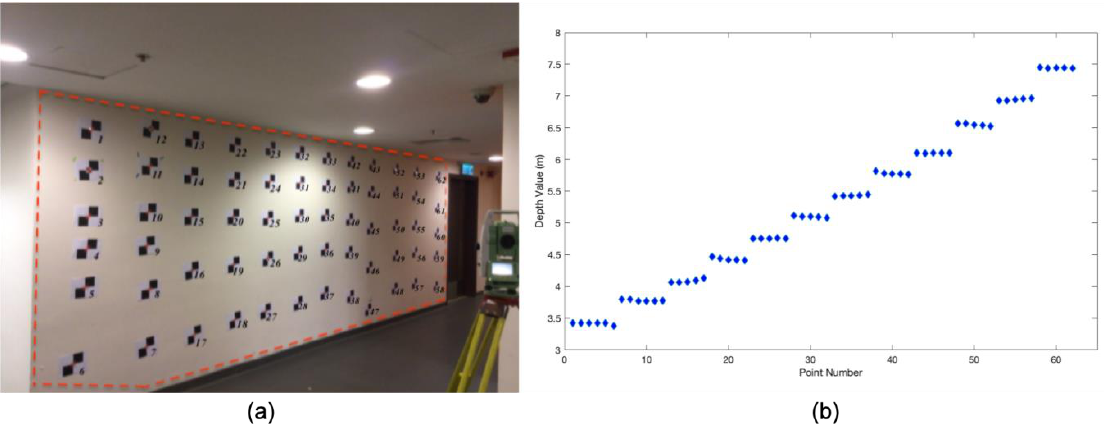
Figure 12. ( a ) Test area of the plane fitting experiment, ( b ) true depth value of the control points.